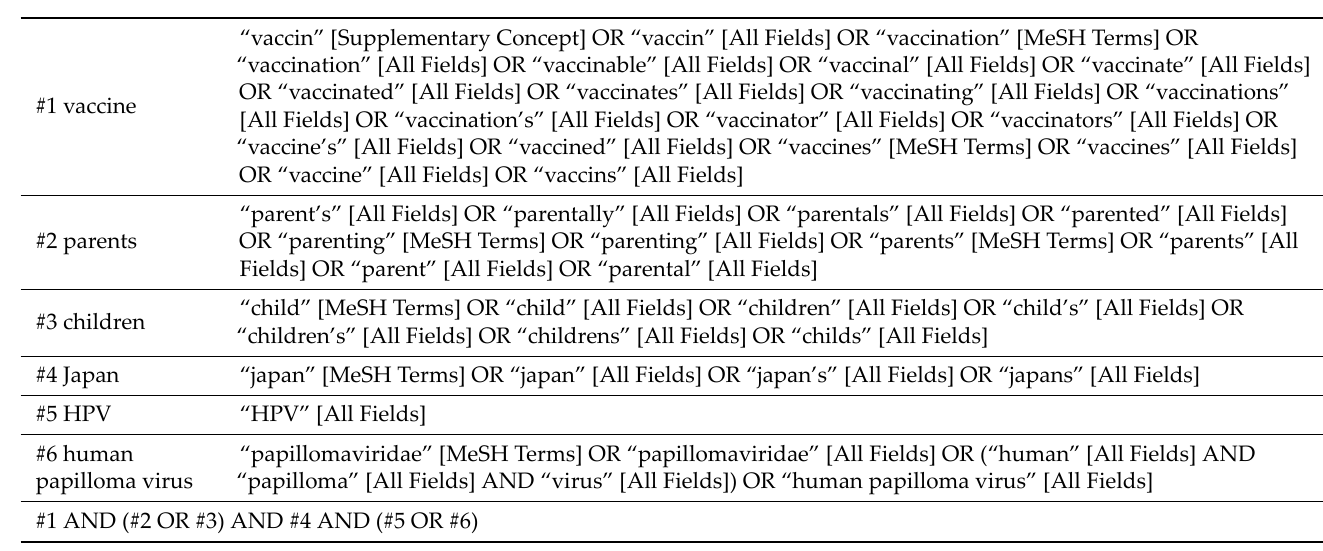
Table 1. Search terms used for the literature search.